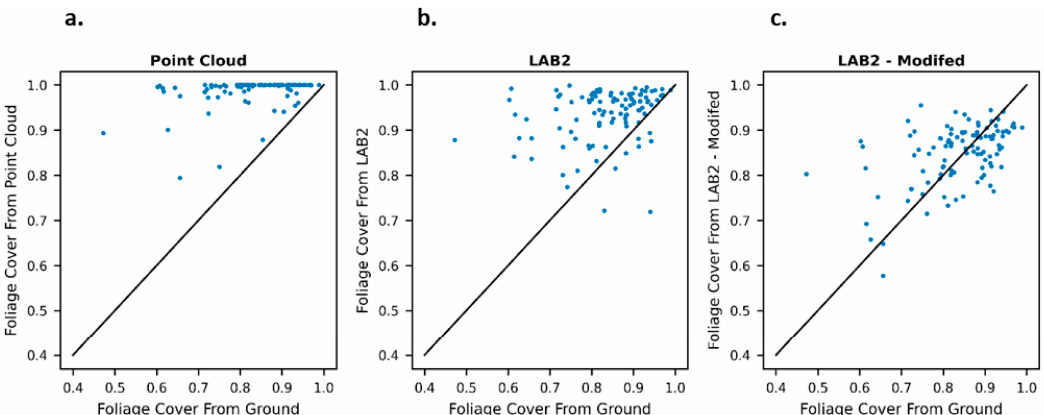
Figure 6. Comparison between the estimates of foliage cover (FC) generated from the ( a ) normalized photogrammetric point cloud, ( b ) the UAS orthomosaic using the LAB2 method, and ( c ) the UAS orthomosaic using the modified LAB2 method. The solid black line indicates the 1:1 relationship. FC is shown as decimal percentages between 0 and 1 with 1 indicating 100%